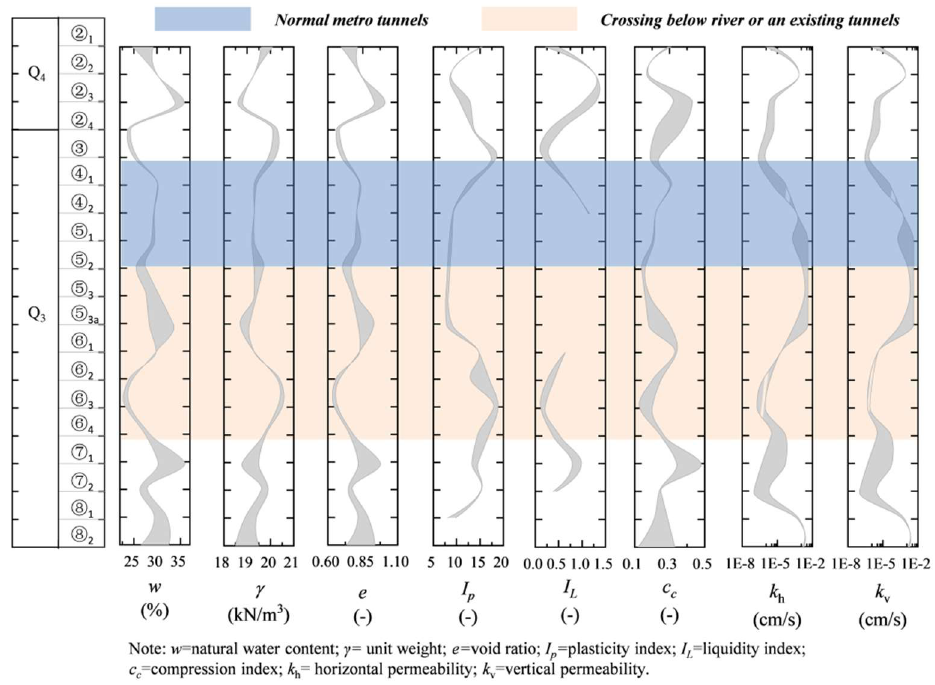
Figure 3. Soil profiles and geotechnical parameters of water-rich soft strata in Changzhou.